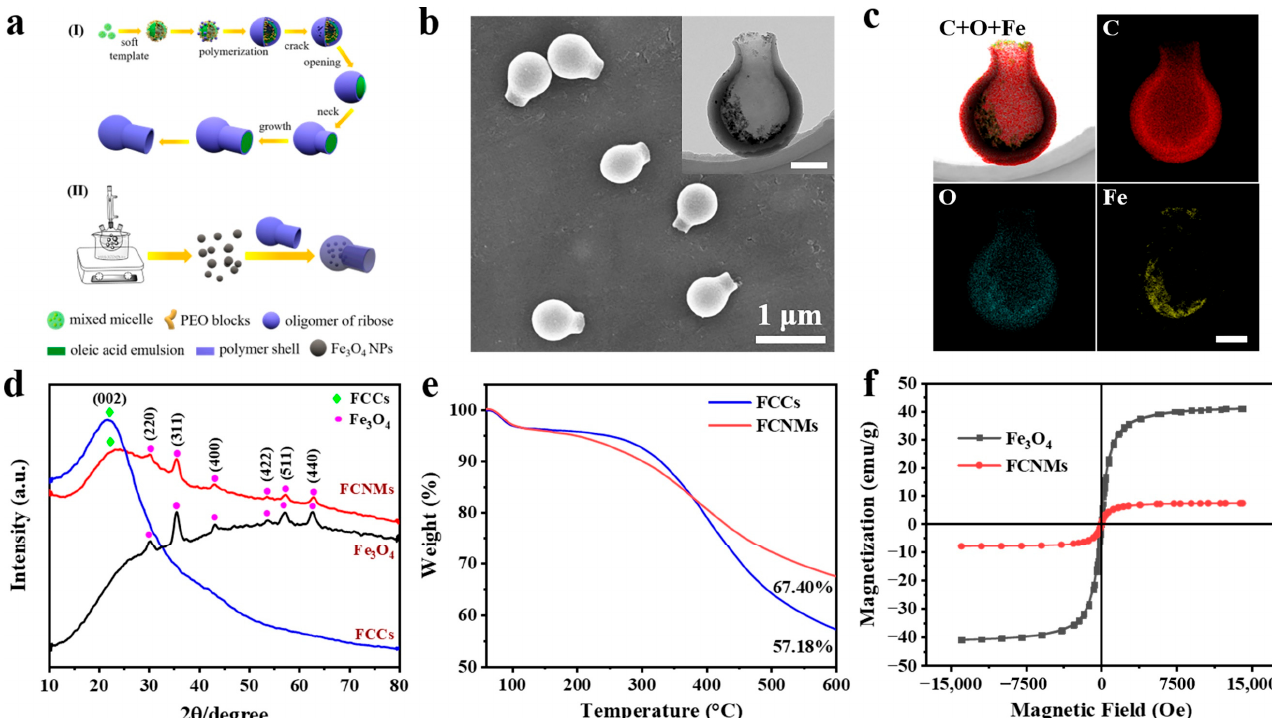
Figure 2. Fabrication and characterizations of the FCNMs. ( a ) Schematic illustration of the experimental procedures. ( b ) SEM image of as-prepared FCNMs (The inset is the TEM image of a typical FCNM. Scale bars: 200 nm.). ( c ) Corresponding EDX images of the distribution of C, O and Fe. Scale bars: 200 nm. ( d ) XRD patterns of the Fe 3 O 4 NPs, FCCs and FCNMs. ( e ) TG curves of the FCCs and FCNMs. ( f ) Magnetic hysteresis loops of the Fe 3 O 4 NPs and FCNMs.